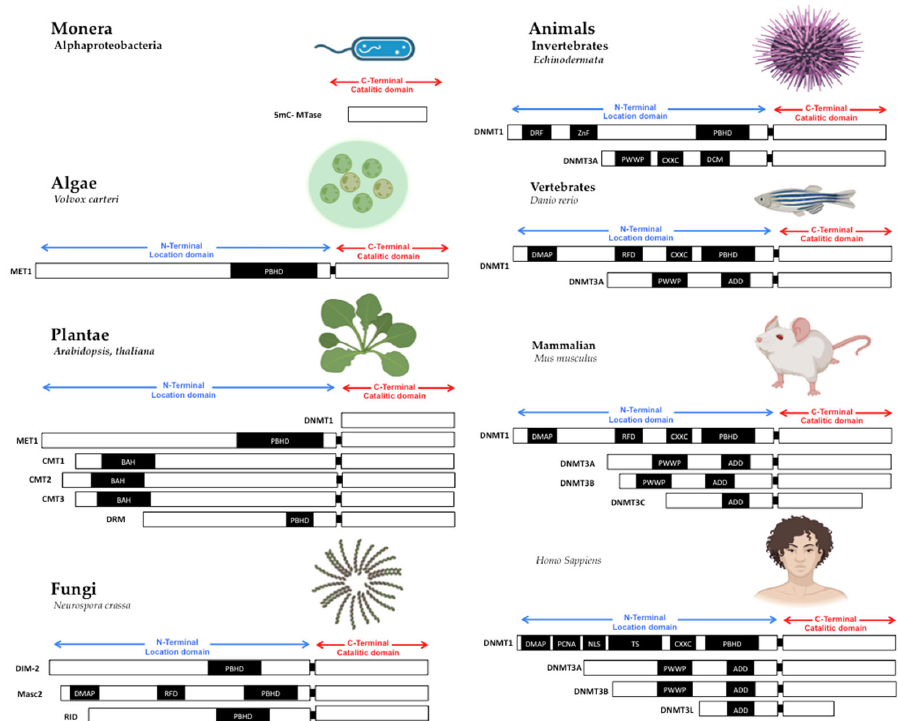
Figure 1. Structure of DNA methyltransferases. The DNMTs family is the DNA methylator in living beings. DNMTs have two domains: catalytic domain in the carboxy-terminal extreme, with the conserved catalytic motives, and location domain in the amino-terminal extreme, with the location and interaction chromatin motives. Monera has the catalytic domain mtase, Alphaproteobacteria. Protists and Algae are composed of MET1, CMT3, and DRM2 protein paralogs; MET1 is an example present in Volvox carteri. Fungi are composed of the protein paralogs: DIM-2, Masc1 and 2, and RID; the example is Neurospora crassa. In animals, Invertebrates, the protein paralogs are DNMT1 and DNMT3, in Echinoderma; Vertebrates, Fishes, DNMT1, and 3, zebrafish has 8 DNMT3 mammalians, the protein paralogs are: DNMT1 and DNMT3A/B/C in Mus musculus, and DNMT1, 3A/B/L in Homo sapiens. Abbreviatures: CD (chromo dominio), DMAP-1, binding domain (DMAP); motif to interact with PCNA (PCDNA); Nuclear localization Signal (NLS); Targeted Site (TS); Motif to Cys-X-X-Cys amino-acids, with zinc fingers (CXXC), Protein Binding Homeo Domain (PBHD); the motif of interaction with pro-trp-trp-pro (PWWP), and ATRX, DNMT3, DNMT3L domain (ADD). Note: Created with Biorender.com, accessed on 21 July